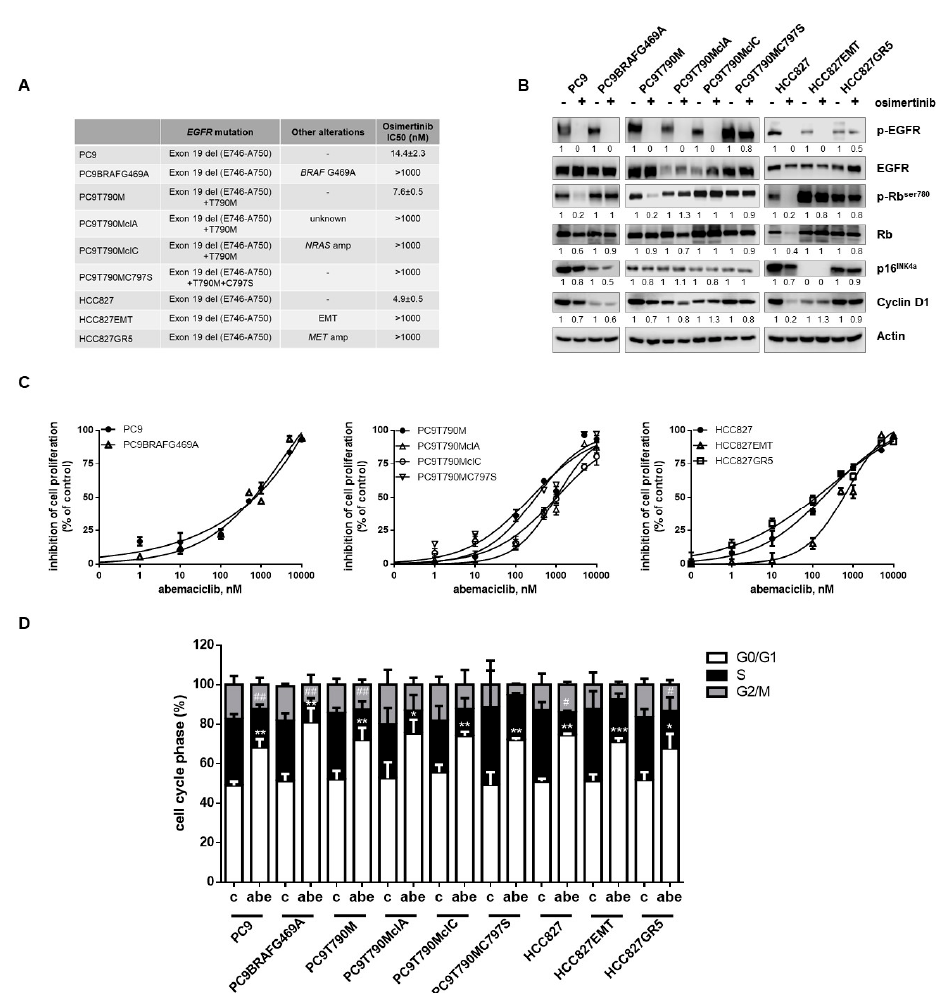
Figure 1. Abemaciclib sensitivity of NSCLC cells resistant to osimertinib. ( A ) Characteristics of NSCLC osimertinib-resistant cell lines used in this study. ( B ) Osimertinib-sensitive and resistant cells were treated with osimertinib (50 nM and 500 nM, respectively) and after 24 h the expression level of p-Rb ser780 , Rb, p16 INK4A and Cyclin D1 were evaluated by Western blotting. Results are representative of at least two independent experiments. ( C ) The indicated cell lines were treated with increasing concentrations of abemaciclib for 6 days. Cell proliferation was assessed by MTT assay; for each cell model, the data are expressed as a percentage of inhibition vs. the corresponding untreated control cells and are means ± standard deviation (SD) of three independent experiments. ( D ) The indicated cell lines were treated with 500 nM abemaciclib for 24 h. Then, the cells were stained with propidium iodide and their distribution in cell cycle phases was determined by flow cytometry. Results are means ± SD of three independent experiments. * p < 0.05, ** p < 0.01, *** p < 0.001 vs. G0/G1 phase of corresponding control cells; # p < 0.05, ## p < 0.01, vs. S phase of corresponding control